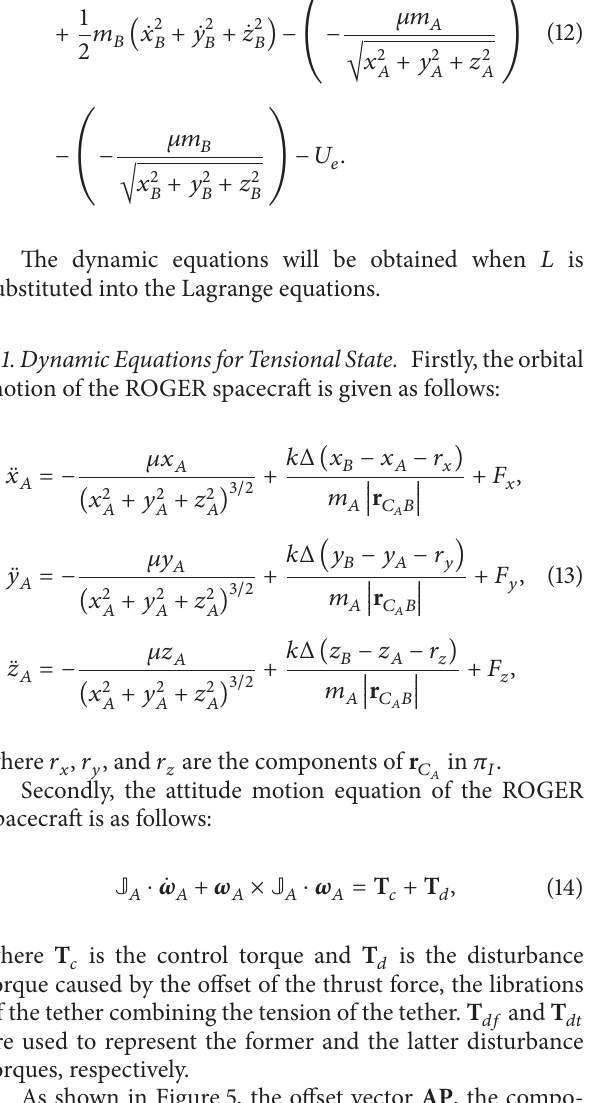
Figure 5: The disturbance